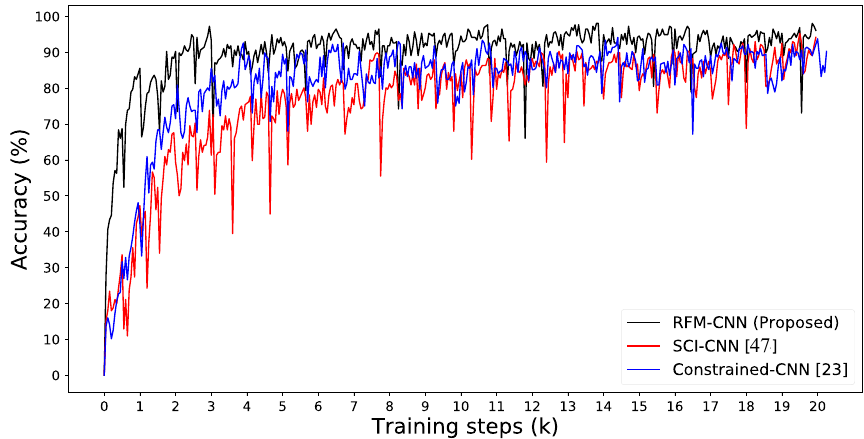
Figure 5. Accuracy curves on training dataset ( D T ) for Constrained-CNN [23], SCI-CNN [47] and RFM-CNN proposed in this work.